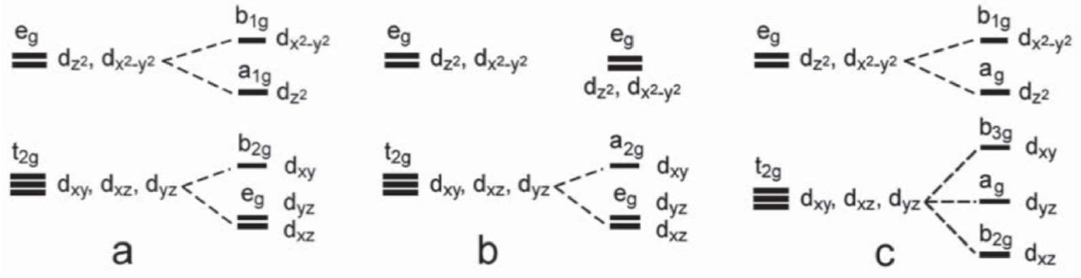
Figure 10. Splitting of t 2g and, e g levels in tetragonal ( a ), trigonal ( b ), and orthorhombic ( c ) distorted environments. Reproduced from [90], Copyright 2007, American Mineralogist.